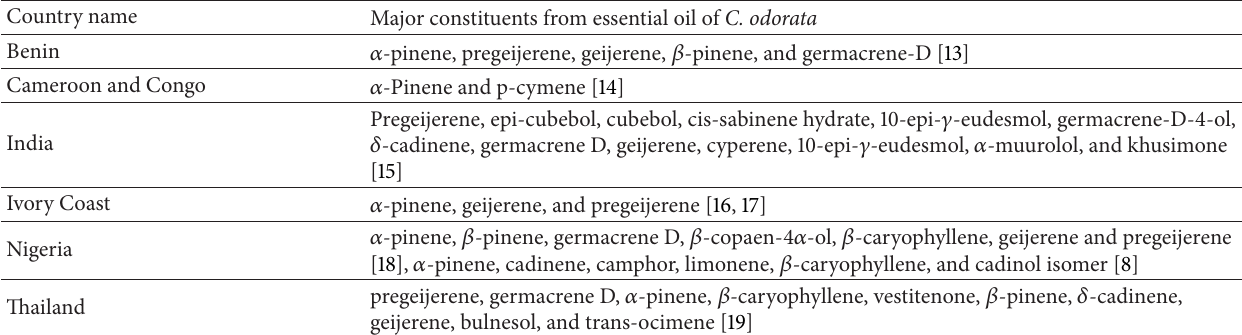
Table 1: Chemical composition of the essential oil of C. odorata from various